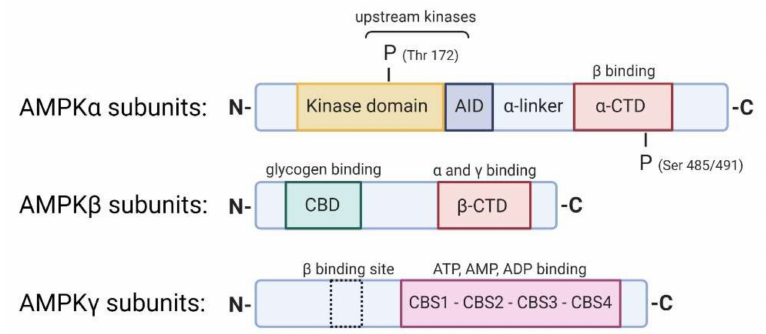
Figure 2. AMPK α , β , and γ subunits. The crystal structure represents the di ff erent domains and specific sites of the α , β , and γ subunits that constitute the AMPK heterotrimeric complex. The AMPK α subunits contain a serine / threonine kinase domain at the N-terminus phosphorylated by upstream kinases on the residue Thr172, directly followed by an autoinhibition domain (AID) that maintains the kinase domain inactive in the absence of AMP and a C-terminus domain ( α -CTD) that interacts with the β subunits. Phosphorylation of Ser 485 / 491 residues on the α -CTD negatively regulates AMPK. The AMPK β subunits have a glycogen-binding domain (CBD) and an α and γ subunit interaction domain ( β -CTD). The AMPK γ subunits present four β -synthase (CBS) domains (CBS1-4) that can bind to ATP, AMP, and ADP. AMP binding initiates the allosteric activation of AMPK and promotes phosphorylation of AMPK by upstream